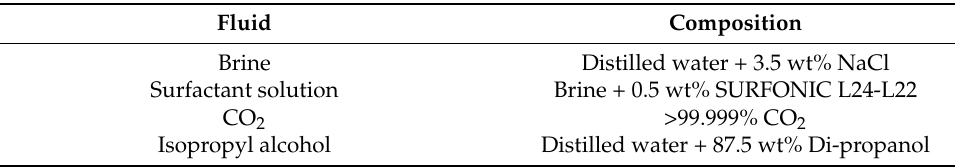
Table 2 for an overview of fluid compositions used in the experimental work. Table 2. Properties of the fluids used in the experimental